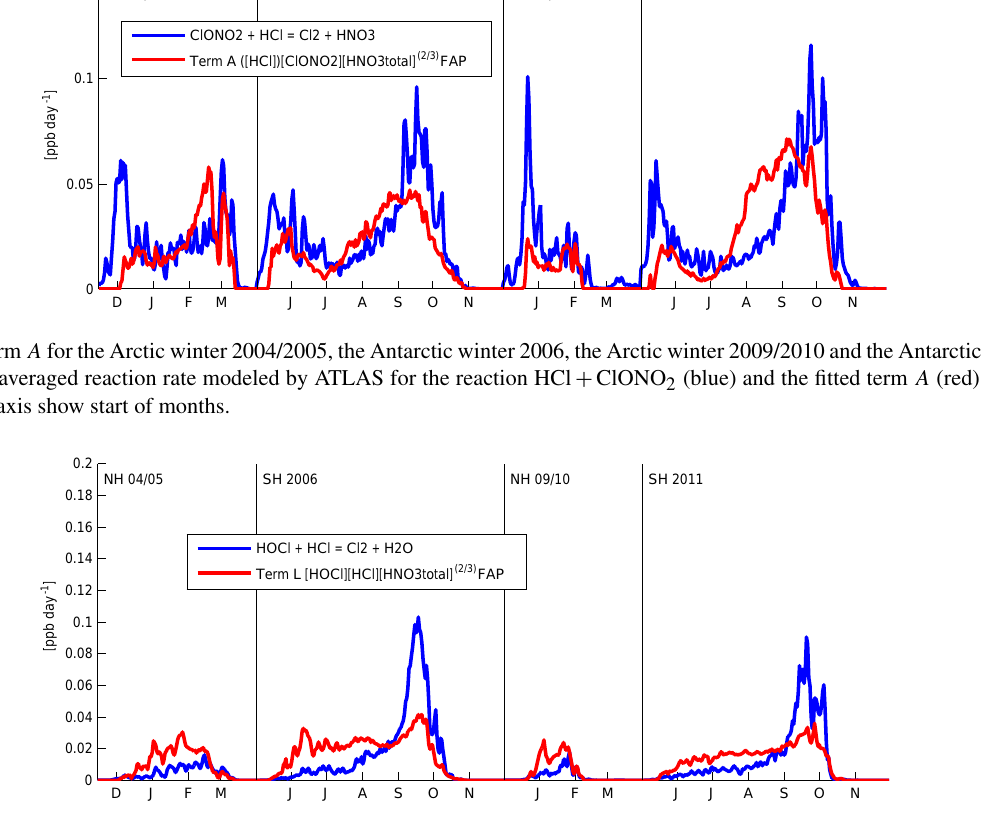
Figure 8. Fit of term L for the Arctic winter 2004/2005, the Antarctic winter 2006, the Arctic winter 2009/2010 and the Antarctic winter 2011 at 54hPa. Vortex-averaged reaction rate modeled by ATLAS for the reaction HOCl + H Cl (blue) and the fitted term L (red). Tick marks on the horizontal axis show start of